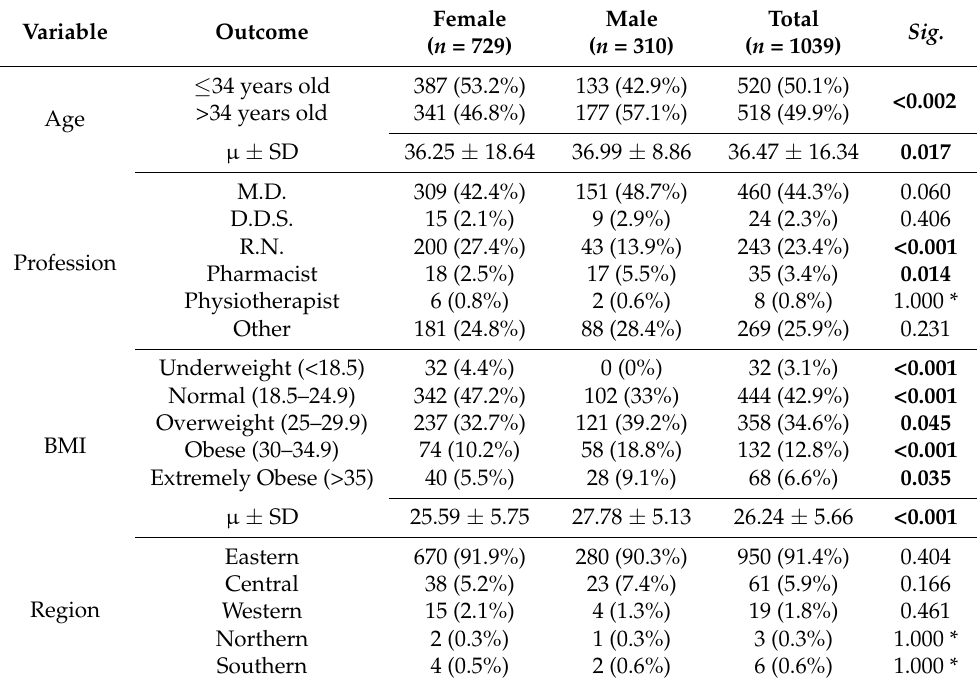
Table 1. Demographic Characteristics of Saudi Healthcare Workers Responding to CoVaST-SA, ( n =